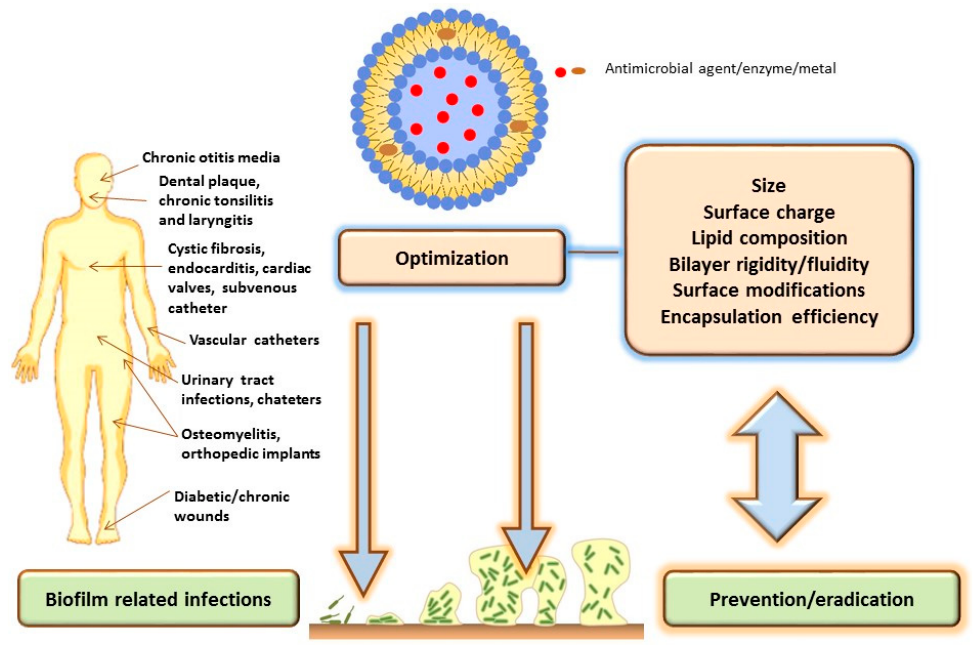
Figure 2. Influence of the liposomal physicochemical properties on the biofilm delivery.